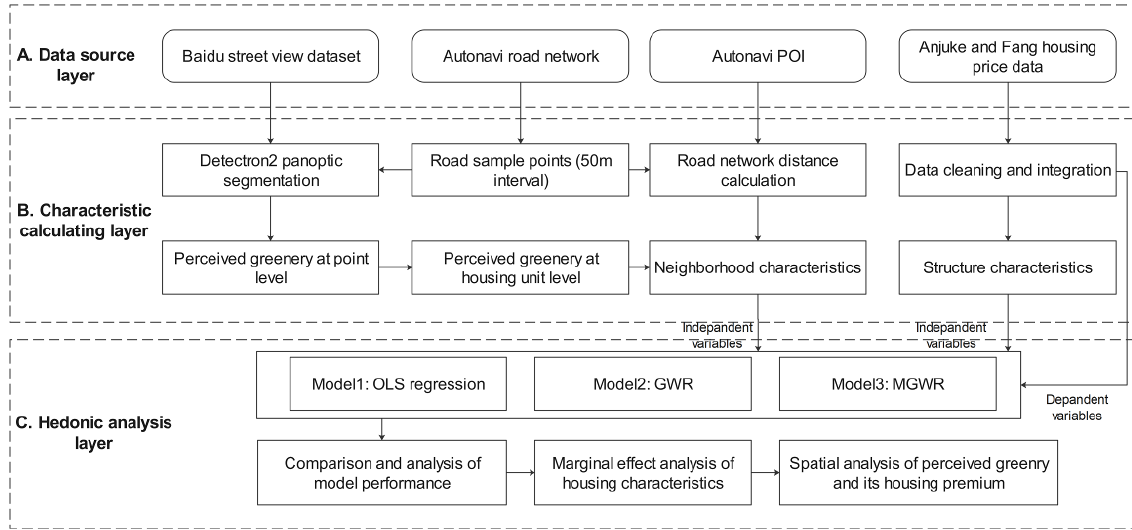
Figure 2. The analytical framework.